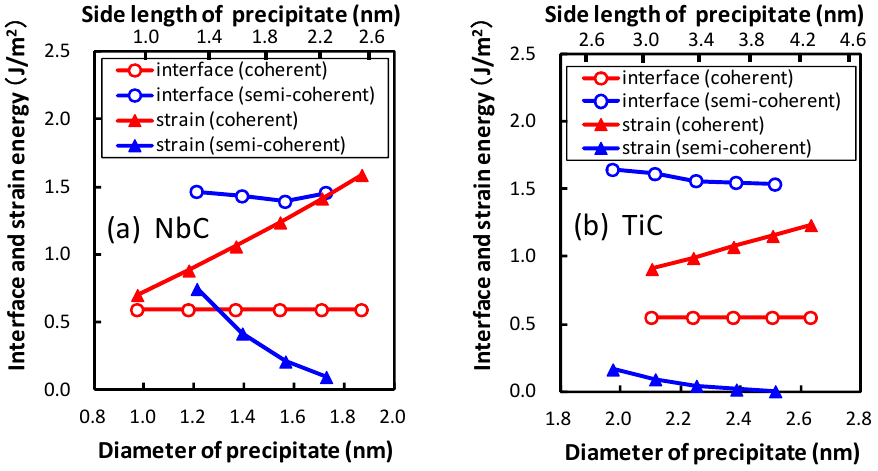
Figure 7. The dependence of diameter of the precipitate on the interface and strain energies for the coherent and semi-coherent precipitates of ( a ) NbC and ( b ) TiC.